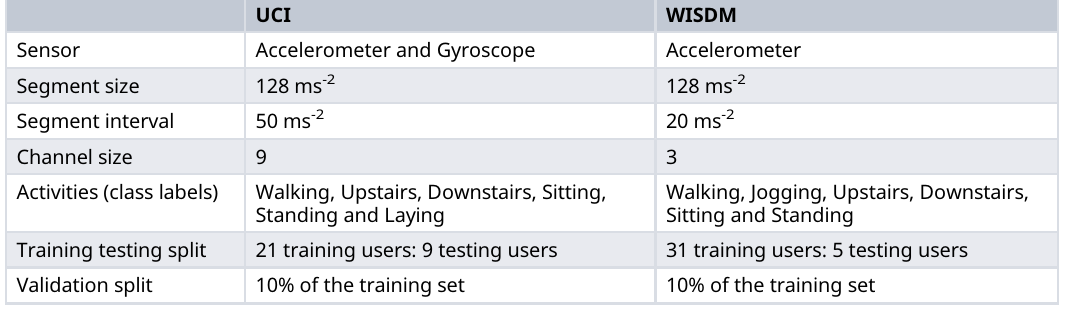
Table 2. Description of UCI and WISDM datasets.